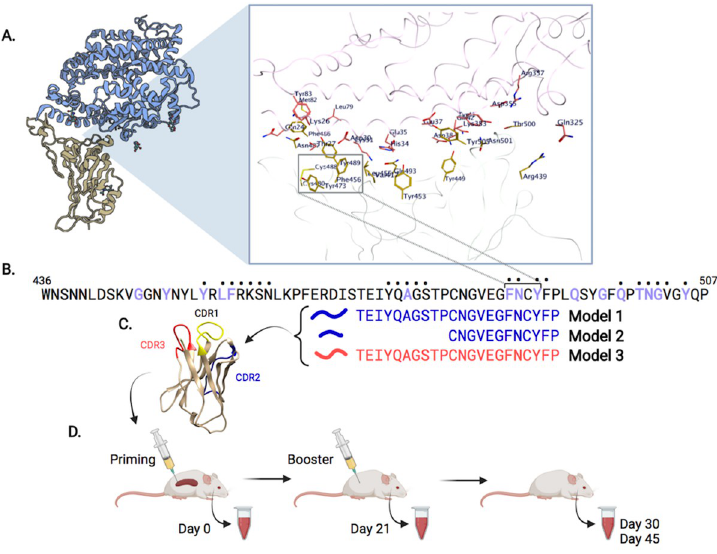
Fig 1. Overview of SARS-CoV-2 epitope selection, protein engineering, and immunization. ( A ) SARS-CoV-2 Spike protein (yellow) interacting with ACE2 (blue), PDB ID: 6M0J. A zoomed view shows SARS-CoV-2:ACE2 interacting residues. ( B ) Spike protein RBM (436–507) sequence. Purple residues indicate ACE2 binding, dots above residues indicate B38 or CC12.1 antibody binding. Immunogens models 1–3 span the putative B cell epitope FNCY (486–489). ( C ) VH62 model with CDR1 (yellow), CDR2 (blue), CDR3 (red). ( D ) Timeline of priming (day 0), and booster shot (day 21), with blood draws (days 0, 21, 30, 45). Figure adapted from images created with BioRender.com.